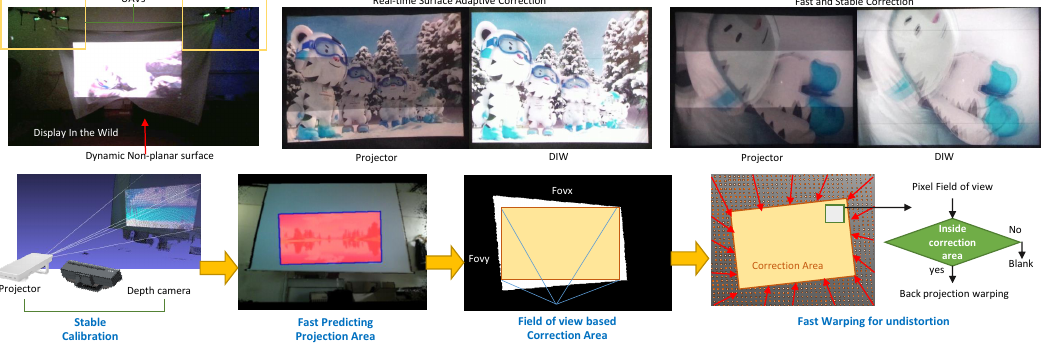
Figure 1. A practical example of our DIW system. We made a screen in the wild having dynamic and non-planar characteristics, using UAVs and a lightweight canvas. Our system can quickly predict/correct the geometric distortions of the